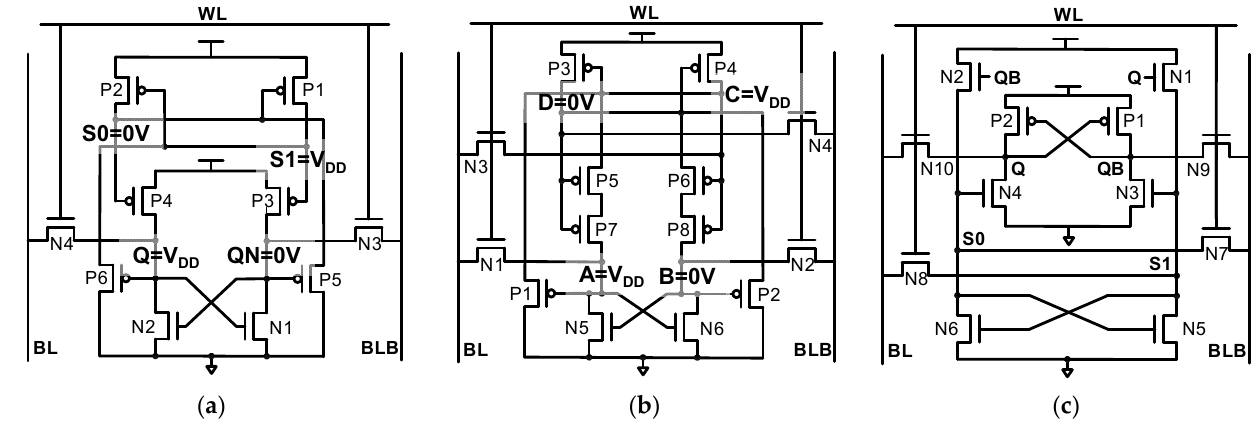
Figure 5. Schematic of ( a ) RHBD-10 T, ( b ) RHBD-14 T, and ( c ) RHPD-12 T SRAM cell.